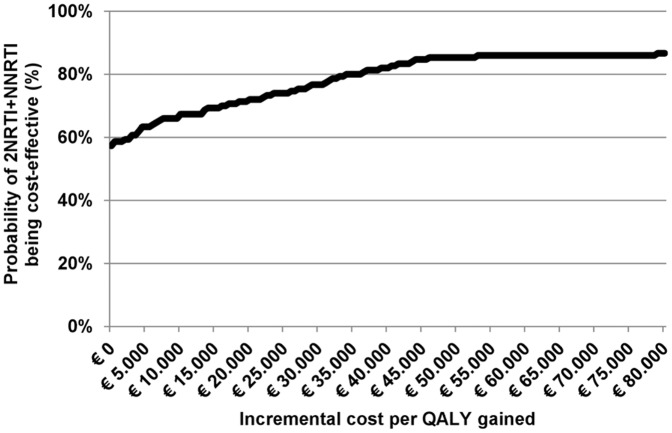
Probabilistic sensitivity analysis: cost-effectiveness acceptability curve for 2NRTI+NNRTI compared with 2NRTI+IP/r as initial antiretroviral therapy.